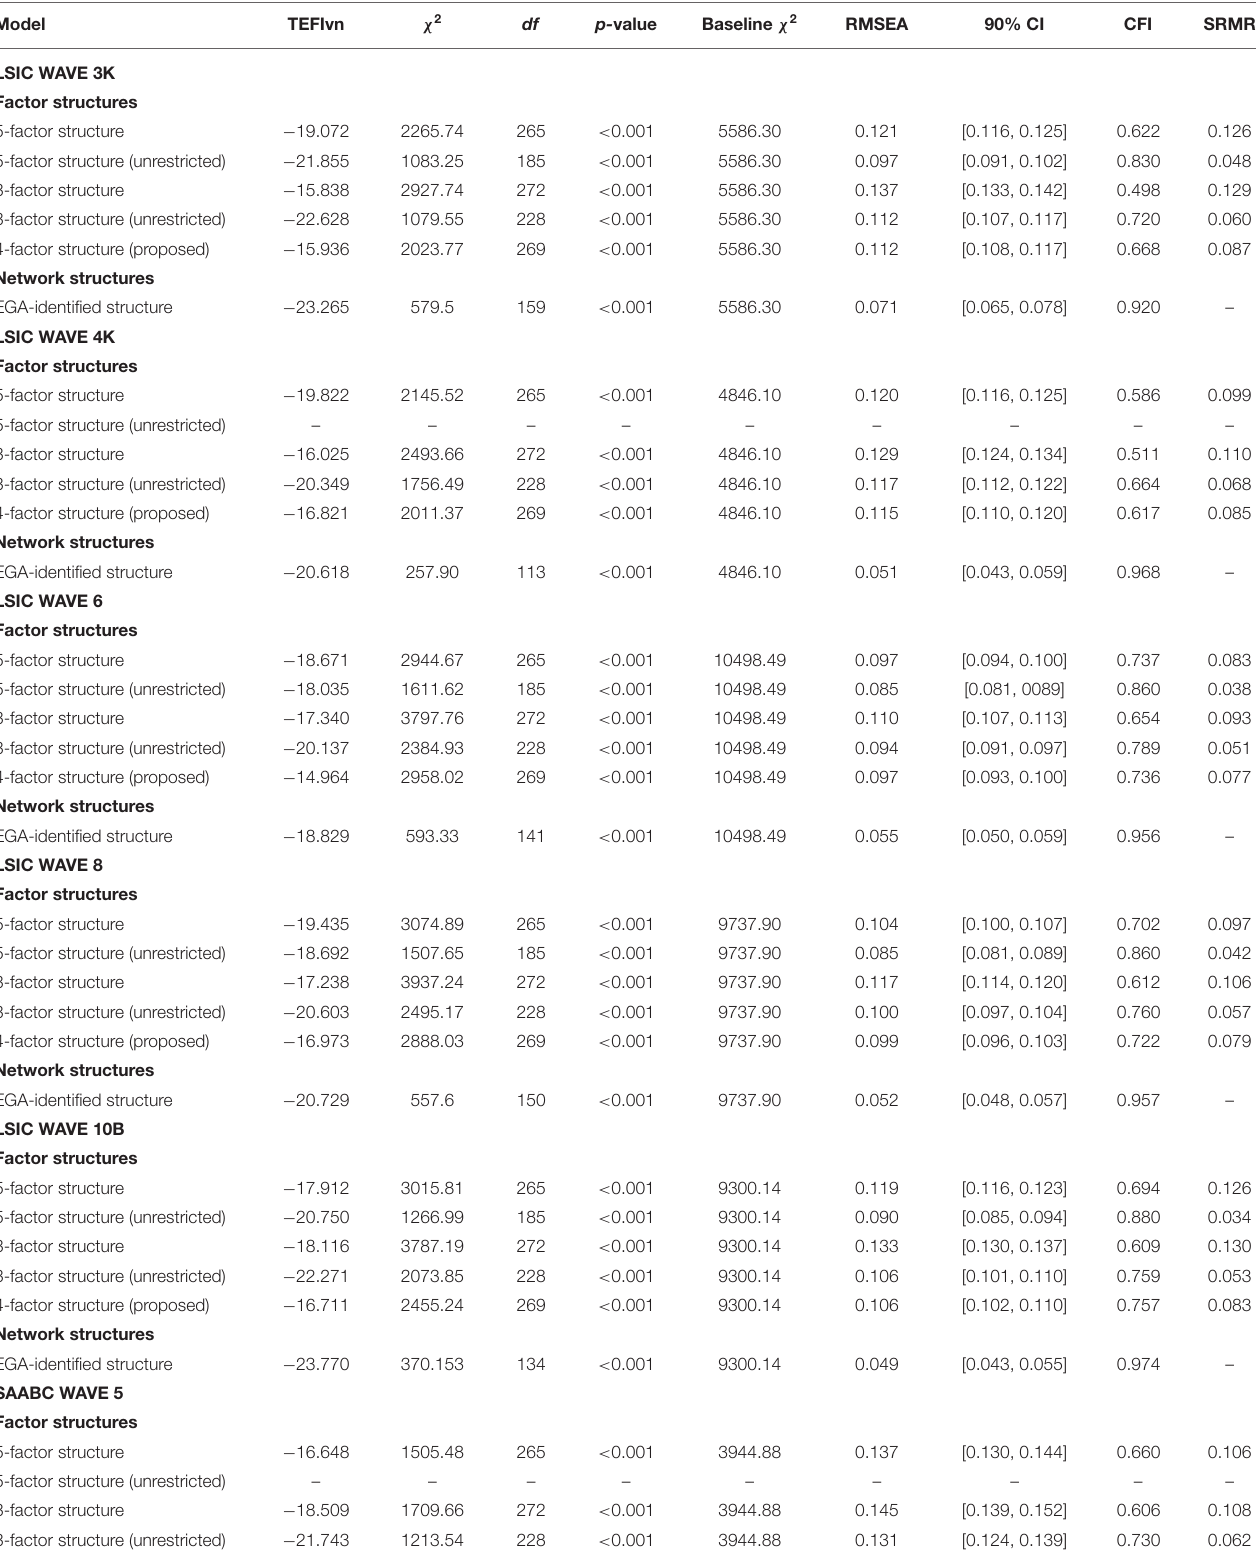
TABLE 4 | Model fit comparison of factor and network models of